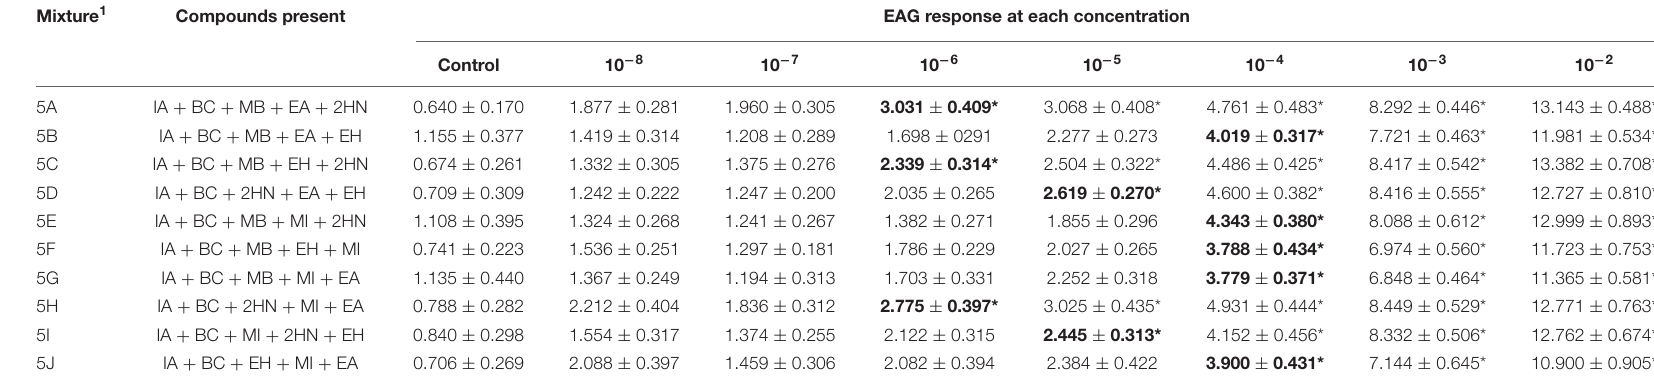
TABLE 5 | Electroantennogram (EAG) responses (mean ± SEM) of female D. suzukii to different concentrations of mixtures with 5 compounds. Mixture 1